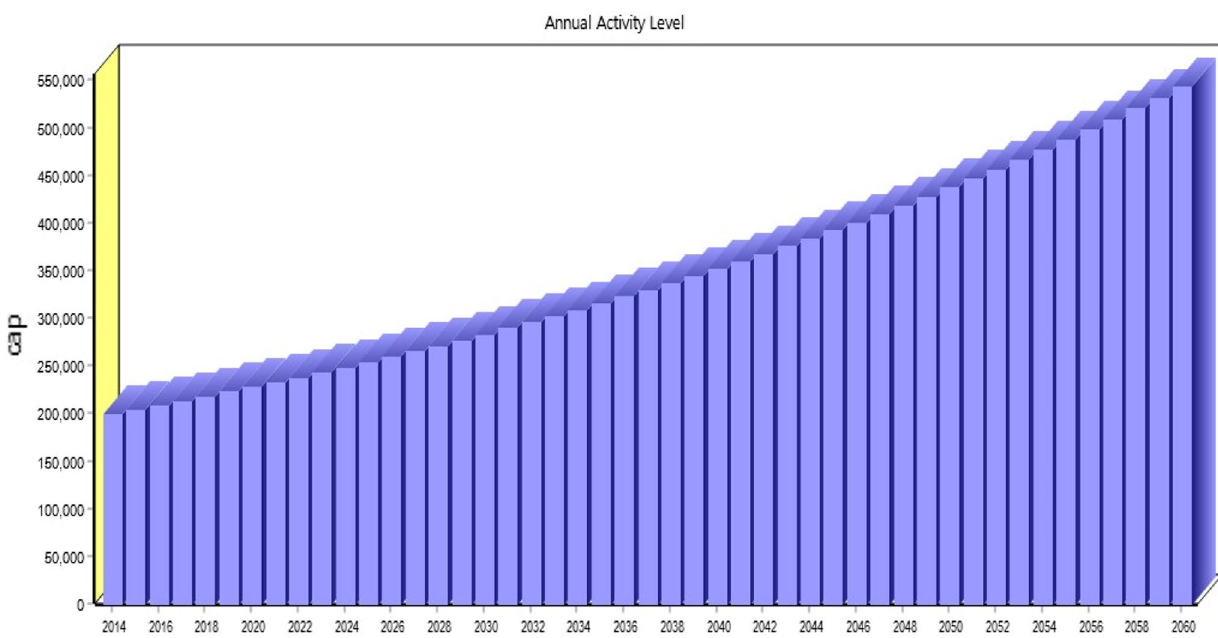
Fig. 4 Evolution of the number of inhabitants in the 2014–2060 reference scenario (rates 2.2%)